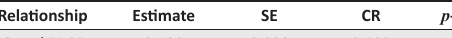
TABLE 7: Maximum likelihood estimates